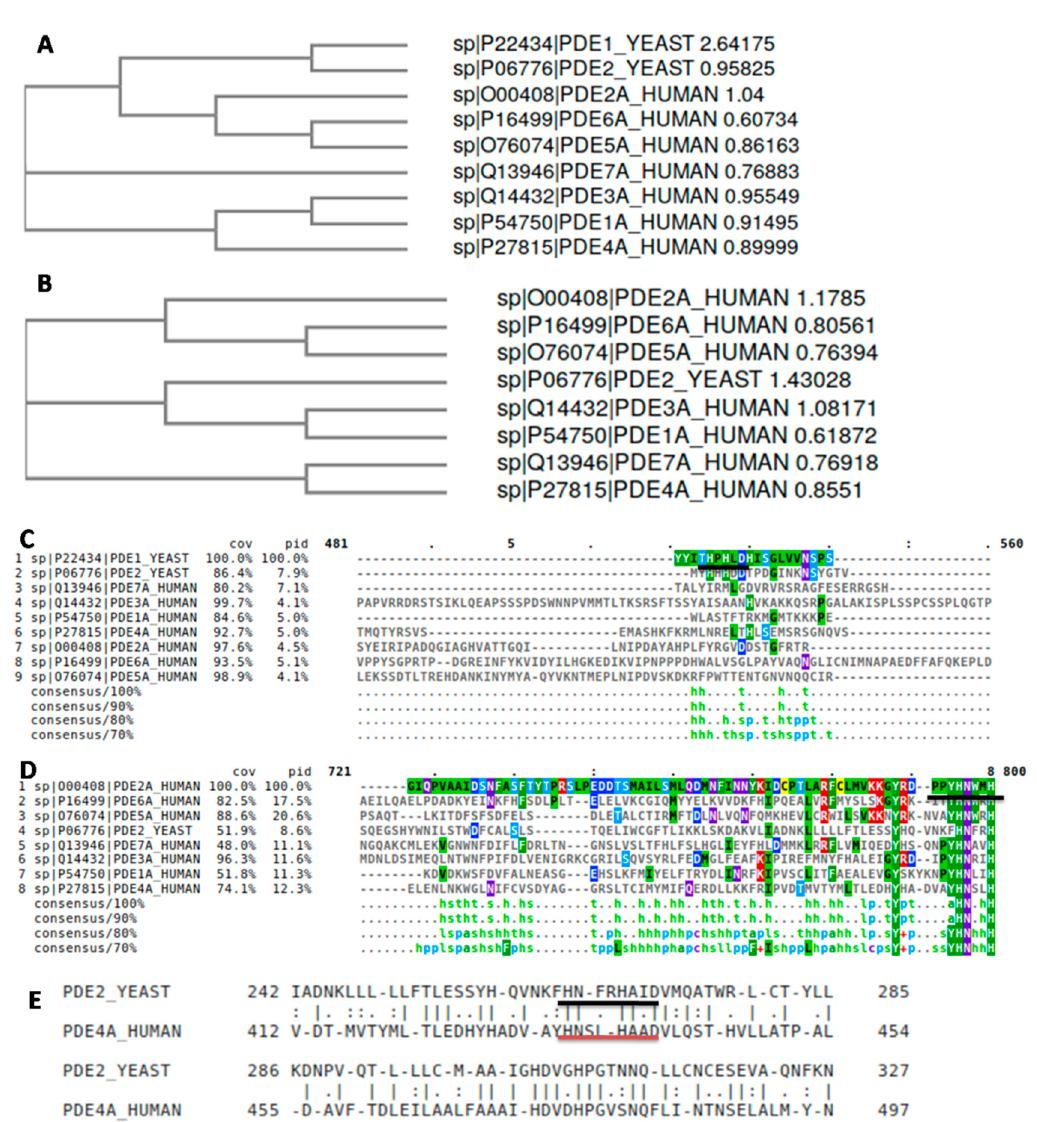
Figure 2. NJ phylogenic tree of all ( A ) human and yeast PDEs and ( B ) without yPDE1; ( C ) detail of MUSCLE multiple alignment for all PDEs; indicated, the yPDE1 active site; ( D ) detail of MUSCLE multiple alignment for all PDEs without yPDE1; indicated, the yPDE2 active site; ( E ) pairwise alignment between yeast yPDE2 and human PDE4A; indicated the active sites.